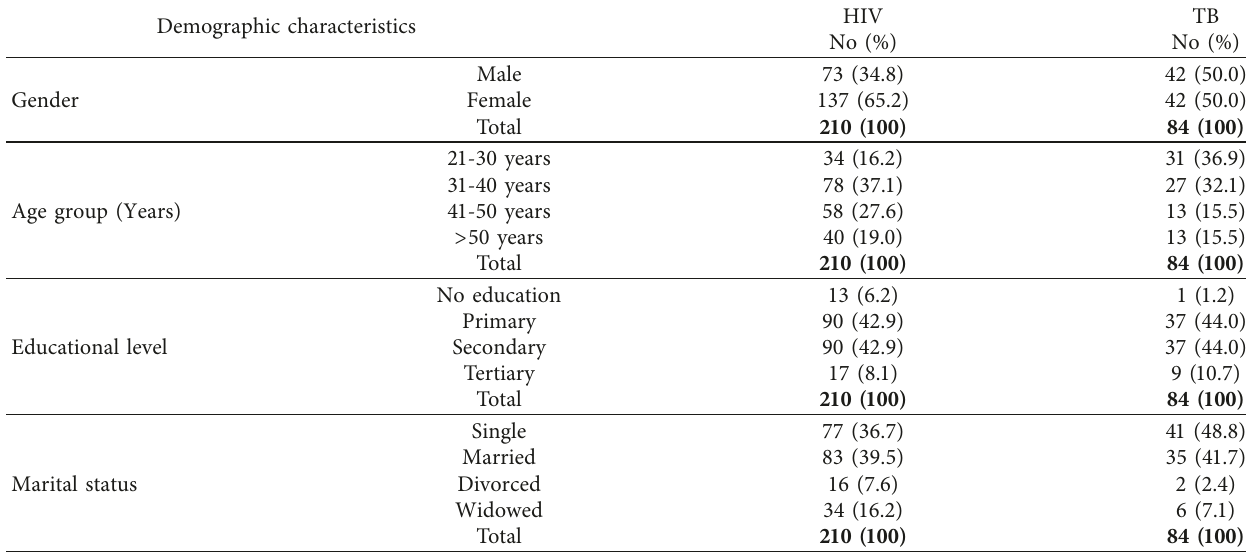
Table 1: Demographic characteristics of TB and HIV participants in Buea and Kumba hospitals.